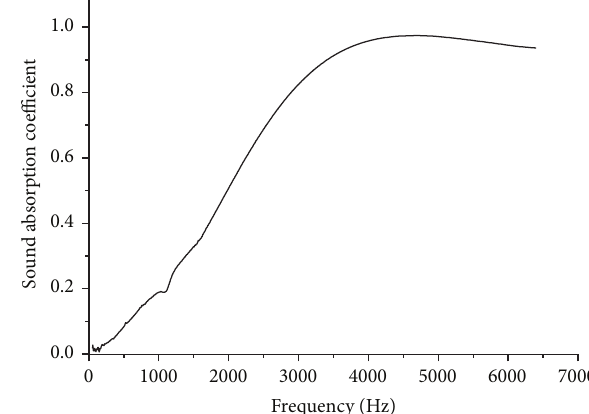
Figure 4: The absorption coefficient of wood fiber/polyester fiber composite